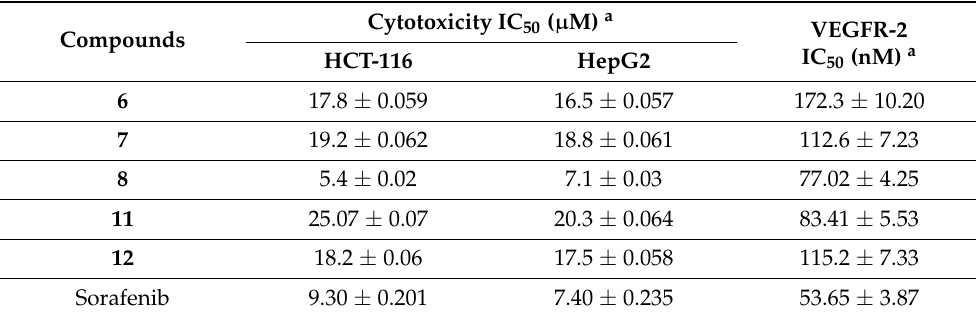
Table 1. In vitro cytotoxic of compounds 6 , 7 , 8 , 11 , and 12 against HCT-116 and HepG2 cell lines and in vitro inhibitory activities against VEGFR-2.